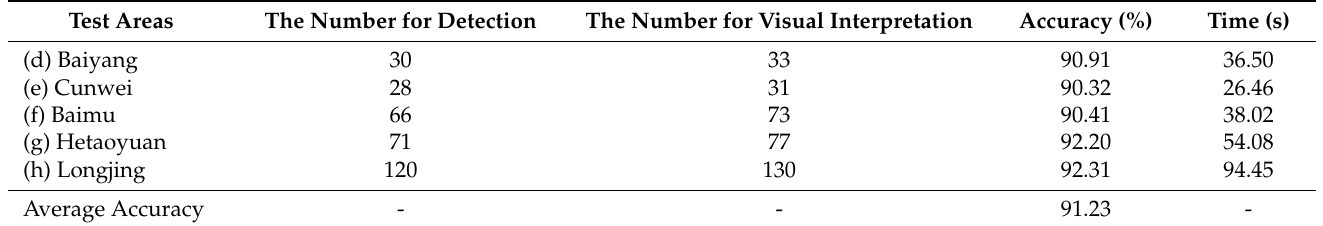
Figure 15. The examples of detection results by YOLOv5s-ViT-BiFPN. Table 2. The comparison of visual interpretation and automatic detection for damaged houses in the 5 test areas.